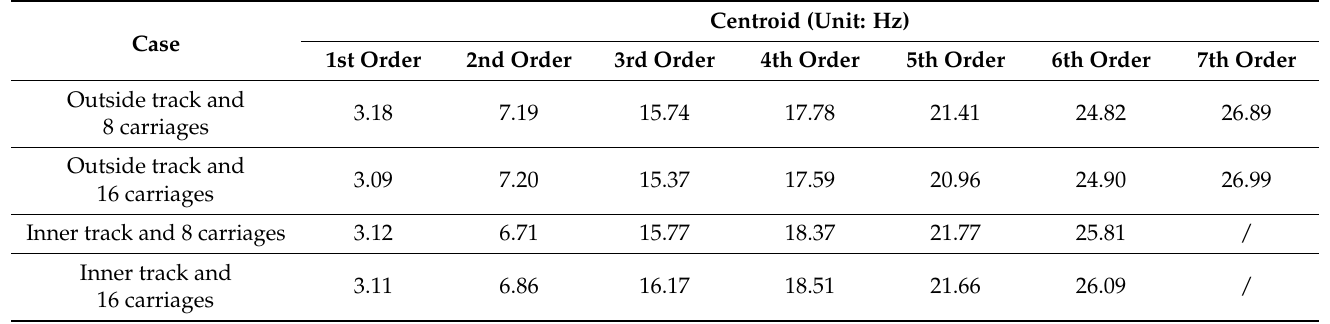
Table 3. Centroid estimation for the main orders of the frequency of train-induced forced vibration.